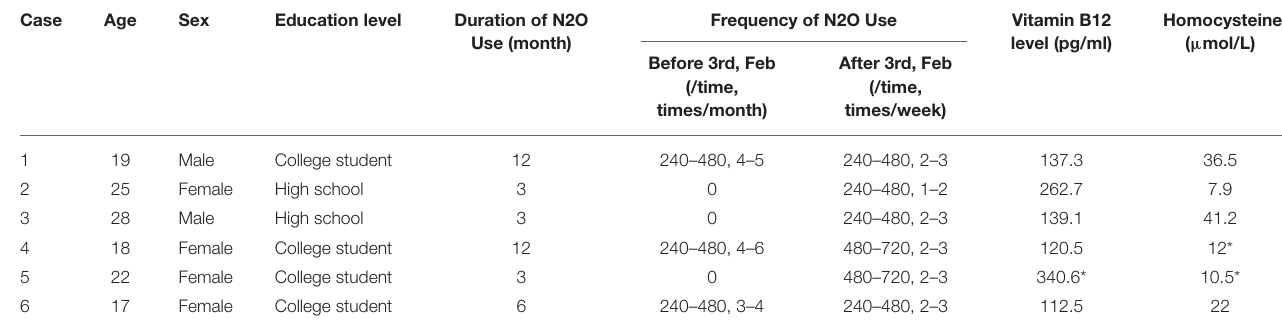
TABLE 1 | Sociodemographic and laboratory characteristics of the case series.